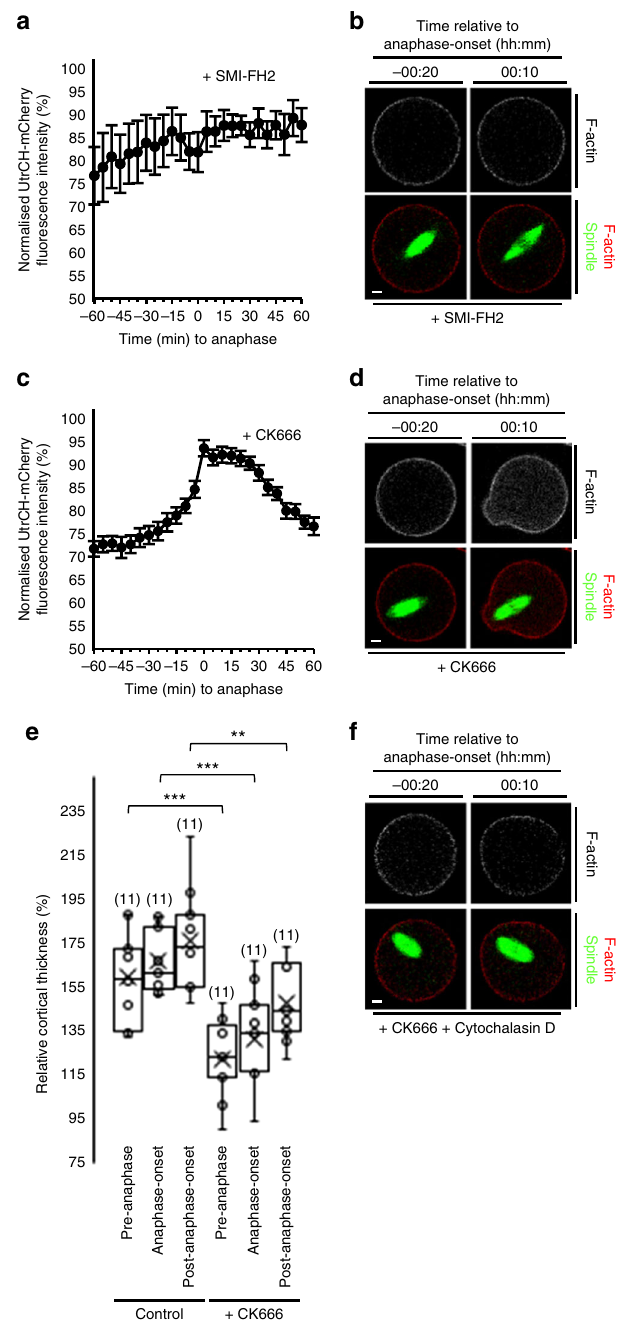
(Fig. 6a and Supplementary Movie 26). In stark contrast, migration after anaphase-onset displaced the midzone periph- erally and resulted in signi fi cantly smaller PBs (Fig. 6b, d, e and Supplementary Movie 27). Strikingly, many spindles (predomi- nantly following Y-27632 treatment, 38 of 43 oocytes) not only migrated after anaphase-onset all the way to the nearest cortex but they then also induced a protrusion (Fig. 6c and Supplementary Movie 28). Throughout their extended period of post-anaphase spindle migration, Y-27632-treated oocytes never exhibited a protrusion before the spindle reached the cortex, reinforcing the dependence of protrusion on spindle migration into the cortex. Notably, and in keeping with the critical importance of cytoplasmic F-actin polymerisation for post- NATURE COMMUNICATIONS| (2018) 9:4029 |DOI: